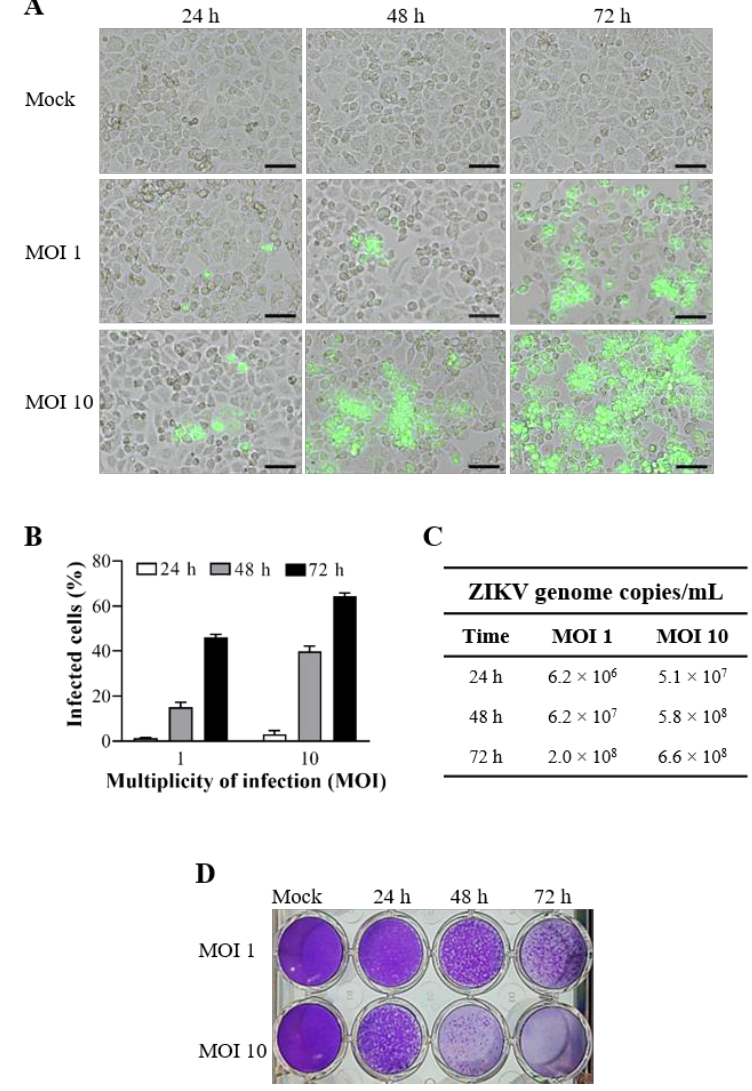
Figure 2. Kinetics of the Brazilian ZIKV strain (ZIKV-BR) infection in human cervical cell line. The cells were mock-infected or ZIKV-infected at MOI 1 and 10 for 24, 48, and 72 h. ( A ) ZIKV – envelope glycoprotein expression (green) was detected by immunofluorescence and images were capture in differential interference contrast microscopy. ( B ) The graph represents the mean ± standard deviation of the percentage of infected cells during the kinetics of infection. The supernatants of cell cultures were collected to evaluate ( C ) viral load by RT-qPCR and ( D ) plaque-forming by plaque assay. The data are representative of 3 – 5 experiments run in duplicate. Bars, 50 µm.